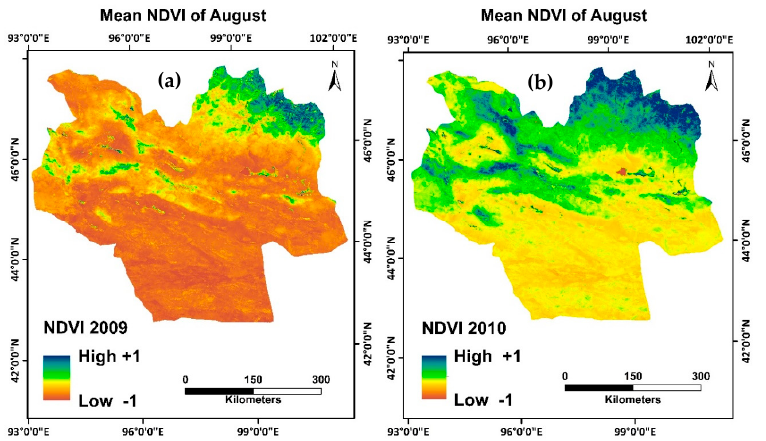
Figure 3. Spatial distribution of MODIS NDVI maps from 2009 to 2010 for the study area. The NDVI map after dzud events: ( a ) Mean NDVI of August 2009; ( b ) Mean NDVI of August 2010.